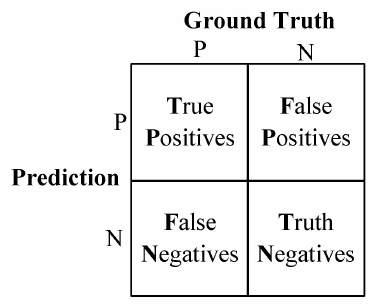
Figure 5. The confusion